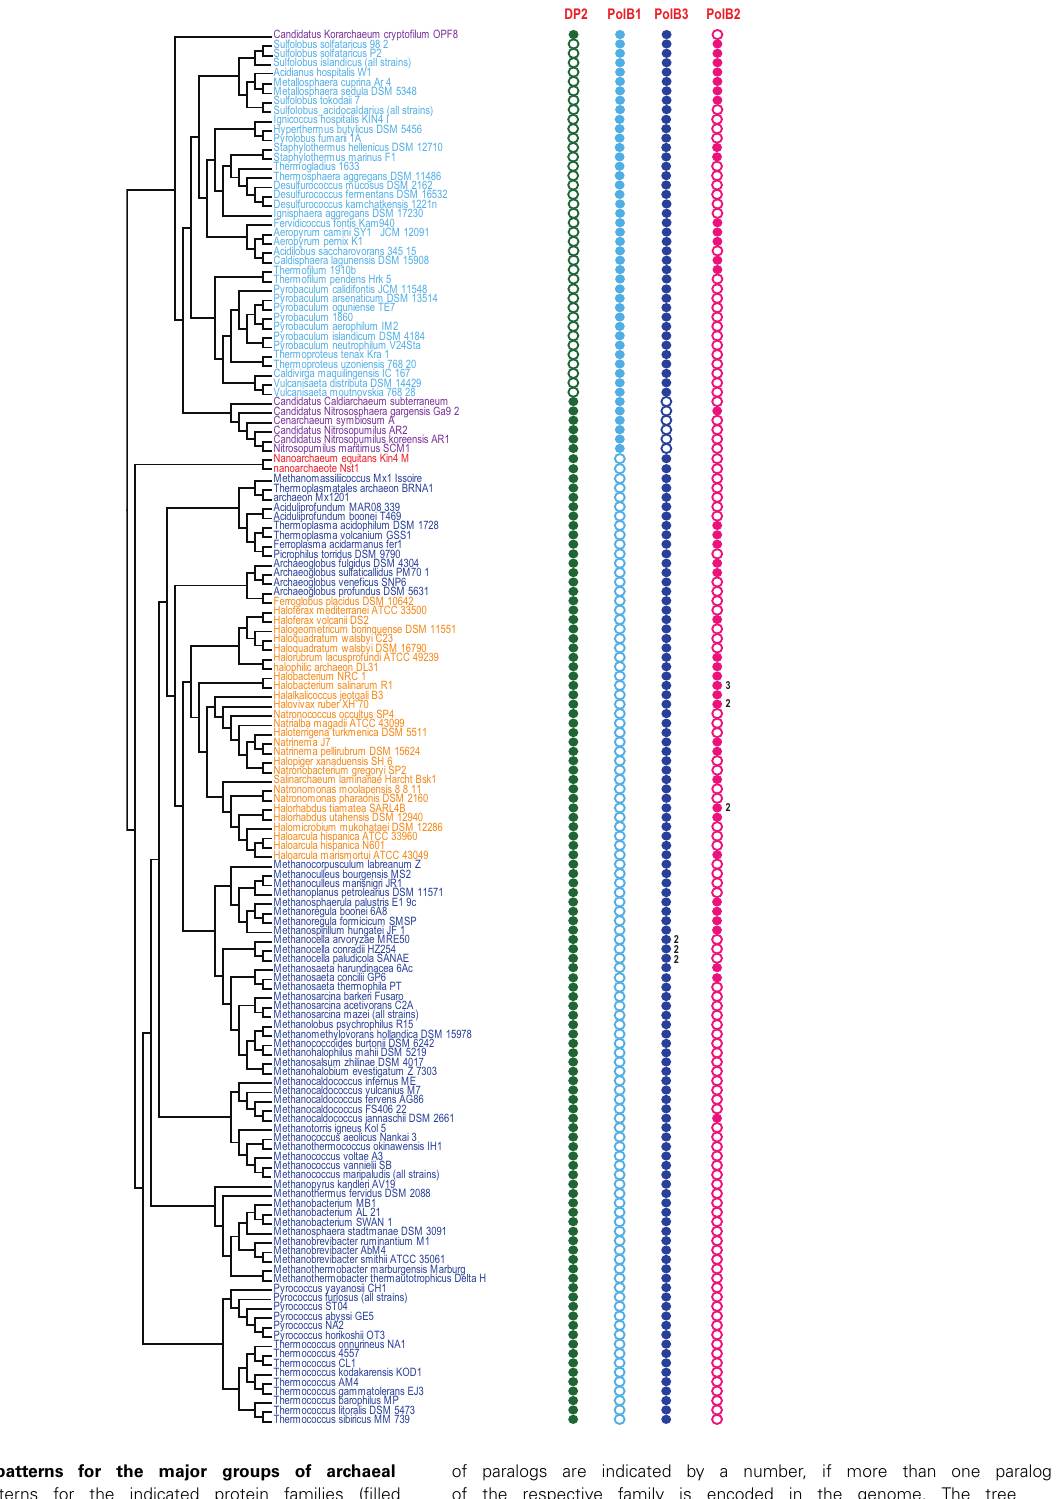
FIGURE 2 | Phyletic patterns for the major groups of archaeal DNAPs. Phyletic patterns for the indicated protein families (filled circles show presence and empty circles show absence) are superimposed over the phylogenetic tree of archaea. The number